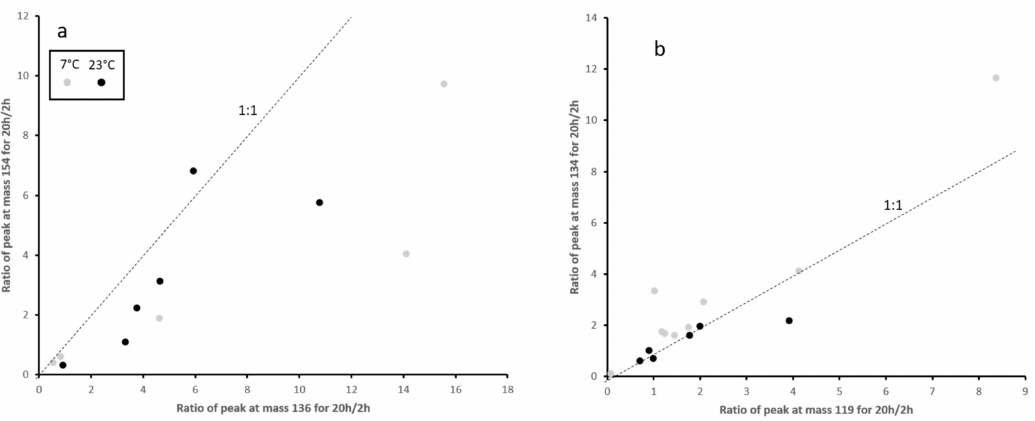
Figure 6. Mass spectra of experiments on 10 wt.% Rosemary loaded as an example.